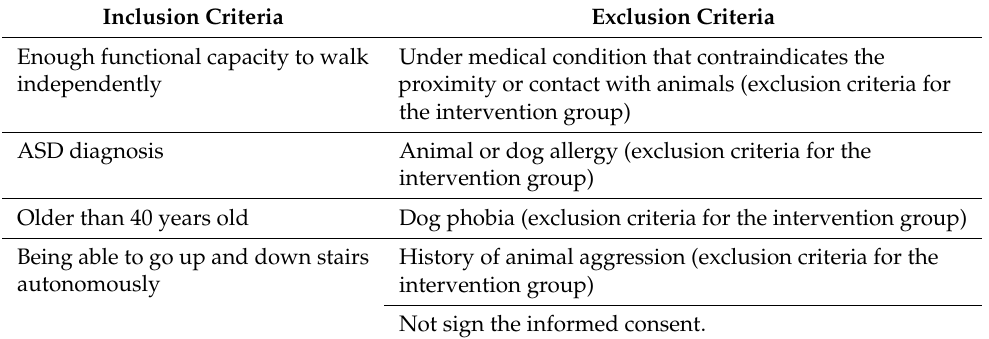
Table 2. Participants’ inclusion and exclusion